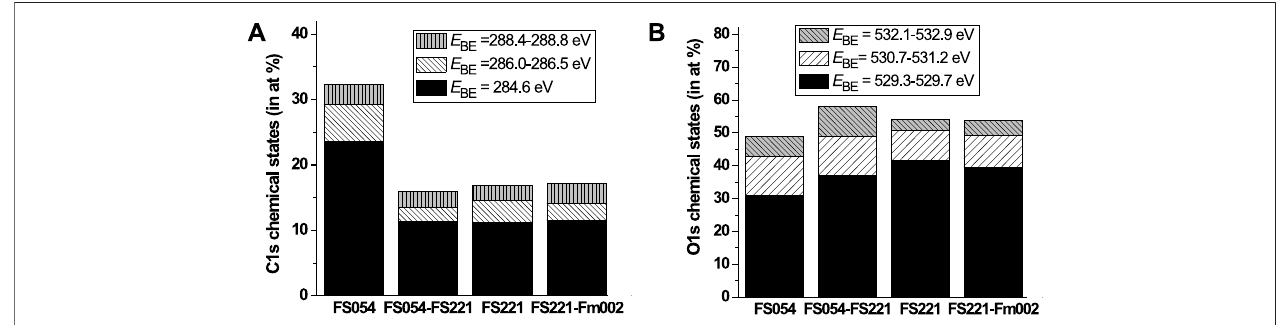
FIGURE 3 | Coexistence of different chemical states at the surface of initial catalysts according to XPS: (A) C1s; and (B) O1s.